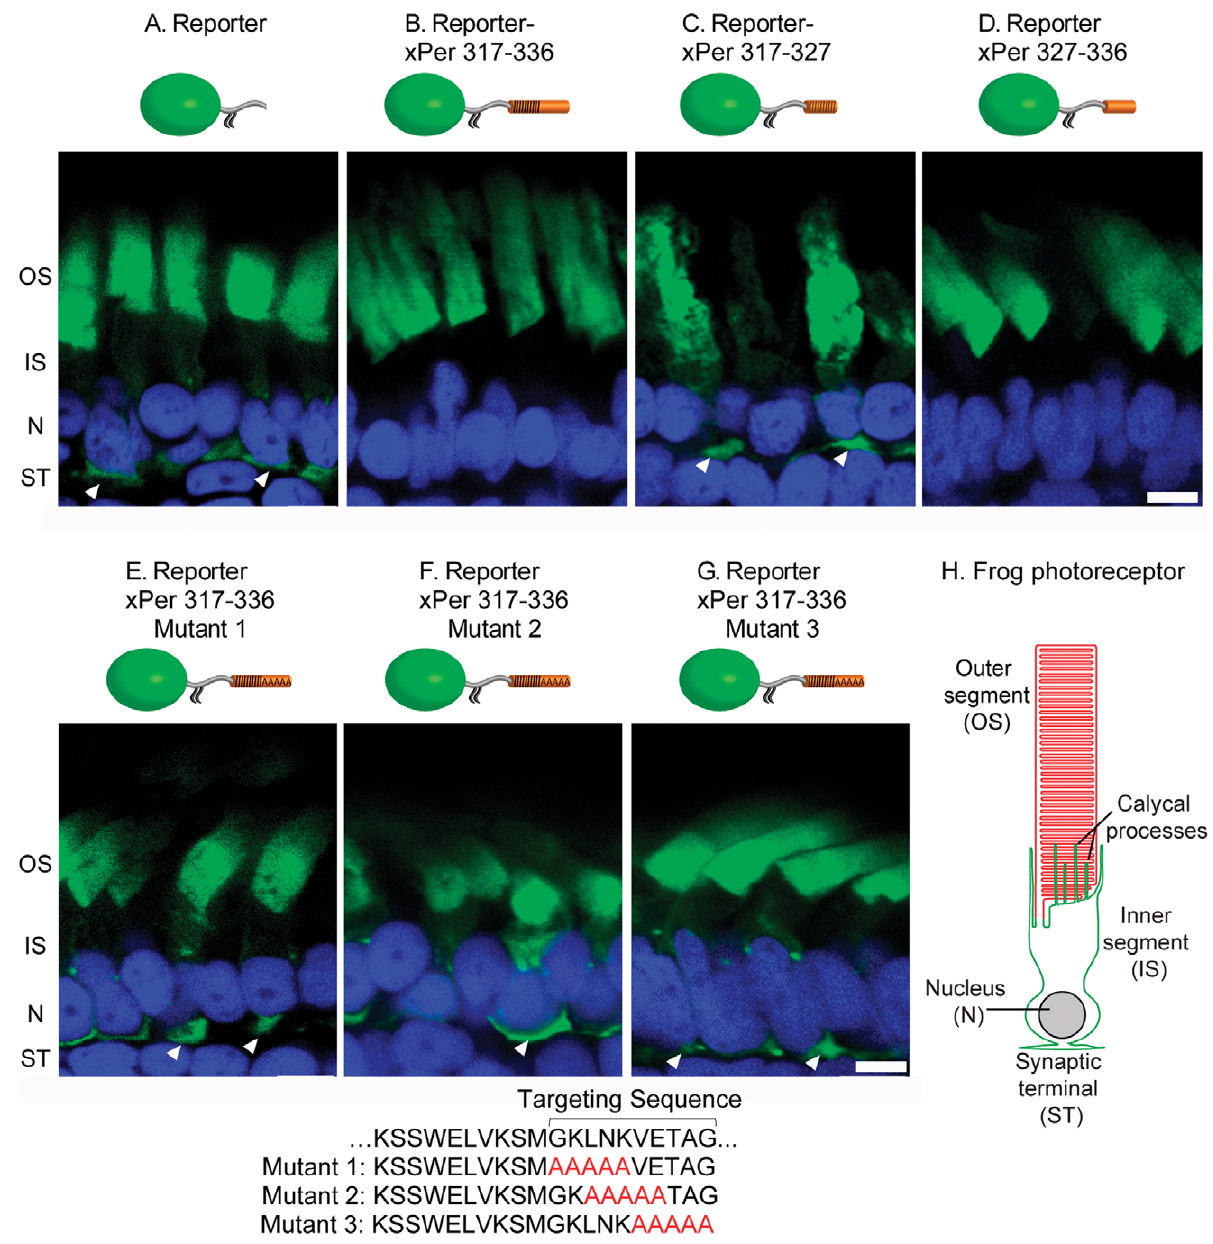
Figure 1. The peripherin targeting signal is contained within a ten amino acid residue stretch. Panels show confocal images of transgenic frog retinas expressing the reporter construct YFP-xRhoCT D 5 (green) fused to the fragments of the peripherin C-terminus illustrated in cartoons above the corresponding panels. Partial mislocalization of several constructs from rod outer segments is marked by white arrowheads. (A) The YFP- xRhoCT D 5 reporter. (B) The reporter fused to xPer 317–336. (C) The reporter fused to xPer 317–327. (D) The reporter fused to xPer 327–336. (E–G) The reporter fused to xPer 317–336 sequences containing polyalanine amino acid substitutions indicated below the panels. Abbreviations are: OS – outer segment, IS – inner segment, N – nuclei, ST – synaptic termini. The nuclei (blue) are stained with Hoechst; scale bar: 5 m m. (H) A schematic of a frog rod photoreceptor illustrating its principle compartments.